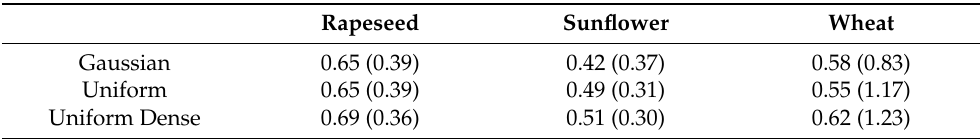
Figure 2. Comparison of inverted LAI from three LUTs (Gaussian, Uniform and Uniform Dense) with the ground measurements. Symbols in red correspond to UAV flights under clouds conditions, and symbols in blue correspond to those under clear illuminations. Table 3. Statistics of inverted LAI from three LUTs (Gaussian, Uniform and Uniform Dense) with ground measurements (R 2 and RMSE in bracket).